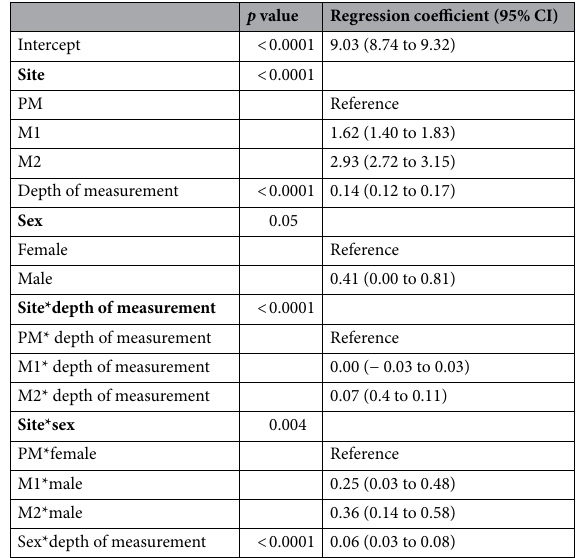
Table 3. Multivariable analysis of alveolar bone width (BW) measurements. PM: second premolar. M1: first molar. M2: second molar. Model selection was done by minimizing the Akaike information criterion (AIC): the 3-way interaction term was removed (AIC from 7700 to 7670).